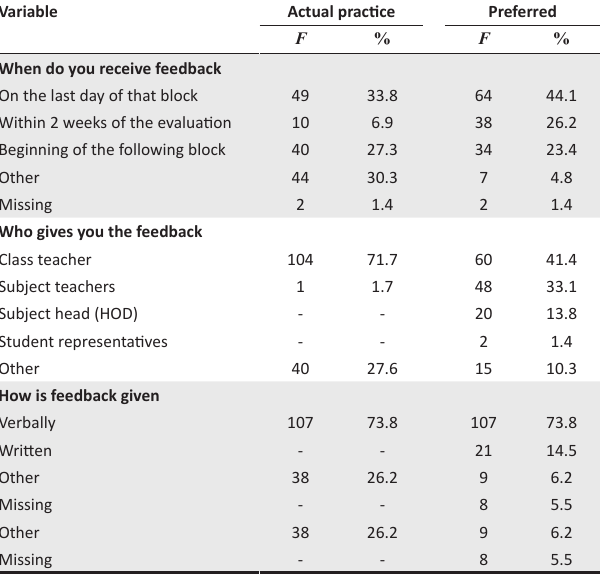
TABLE 5: When and how is feedback communicated to students?